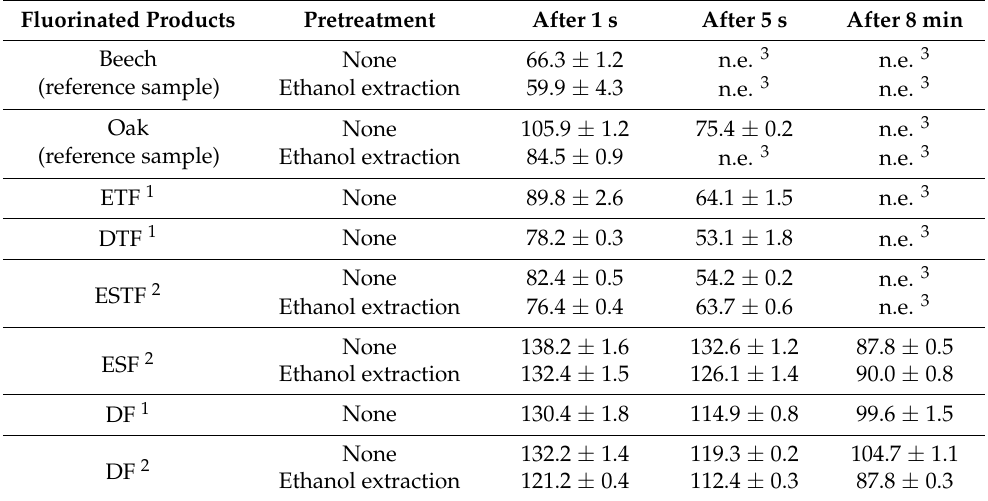
Table 6. Water contact angle ( ϑ c, ◦